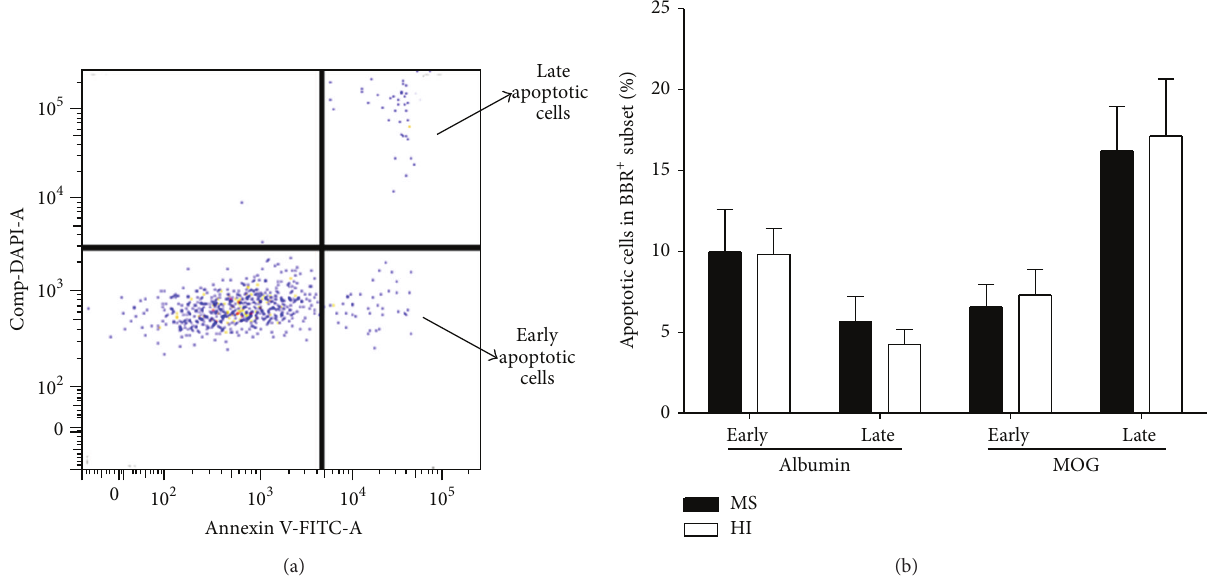
Figure 5: Analysis of apoptosis in MOG-specific B cells. (a) We used annexin V and DAPI to characterize MOG-BBR apoptosis cells in MS ( 𝑛 = 10 ) and HI ( 𝑛 = 10 ). We analysed annexin V + DAPI − (early apoptotic cells) and annexin V + DAPI + (late apoptotic cells) in the MOG-BBR subset. The gating strategy was represented. (b) We compared the frequency of MOG-BBR apoptotic cells in MS and HI in early (ns, 𝑃 > 0.05 ) and late states (ns, 𝑃 > 0.05 ), Mann-Whitney test